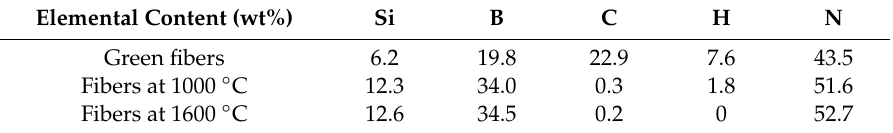
Table 1. Elemental content of composite fibers during di ff erent steps.